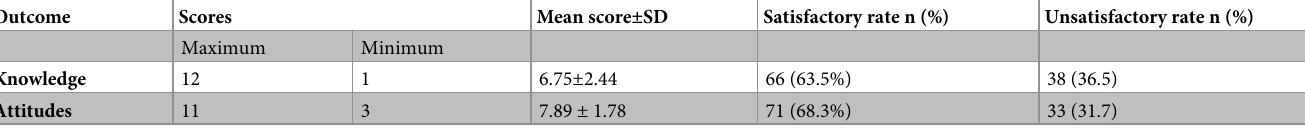
Table 3. Scores obtained by participants on knowledge and attitudes evaluation in Kigali (N =